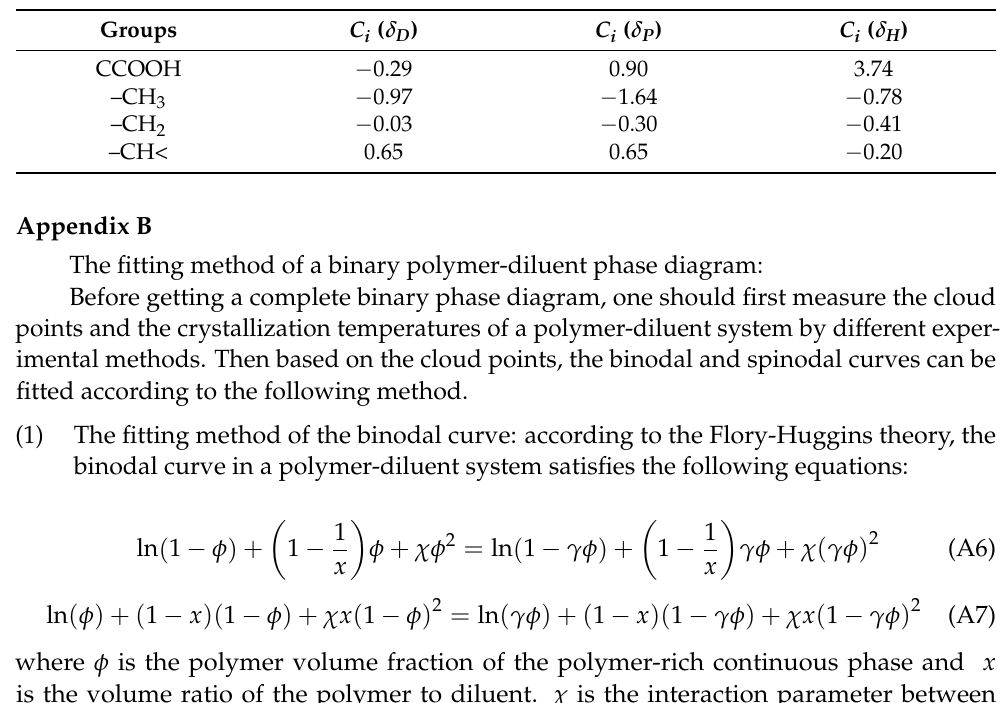
Table A1 listed the group contributions adopted in the manuscript for the HSPs calculation of the four fatty acid diluents. Table A1. The group contributions to contribution values of the dispersion partial solubility parameter, δ D , the polar partial solubility parameter, δ P , and the hydrogen-bonding partial sol- ubility parameter, δ H